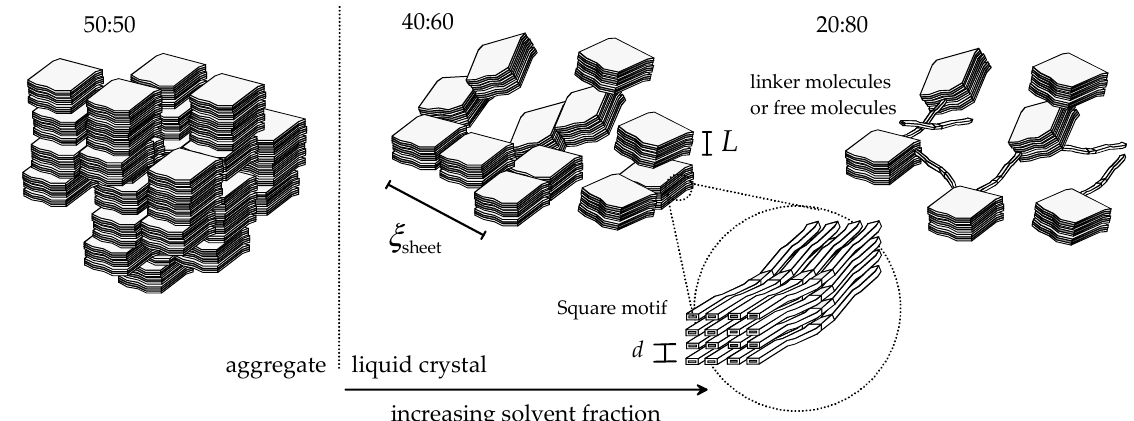
Figure 6. Schematics of polymer 1 in CH 3 CN with increasing polymer-solvent ratio. High polymer fraction (left) promotes aggregation, whereas increasing solvent content facilitates the transition to the lyotropic smectic (and potentially nematic) phase where the size of 2-dimensional objects decreases and linker (or free) molecules appear with further increase. All phases contain smaller square packing motifs regardless of the solvent fraction.